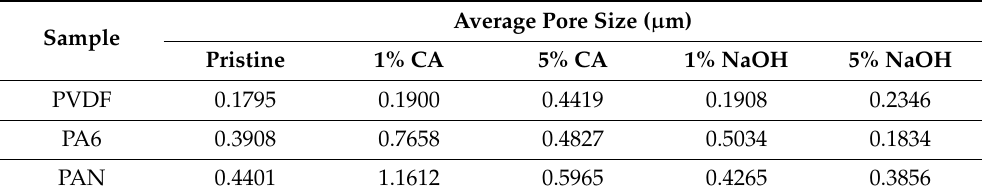
Table 8. Pore size of membranes after the application of chemical cleaning agents.